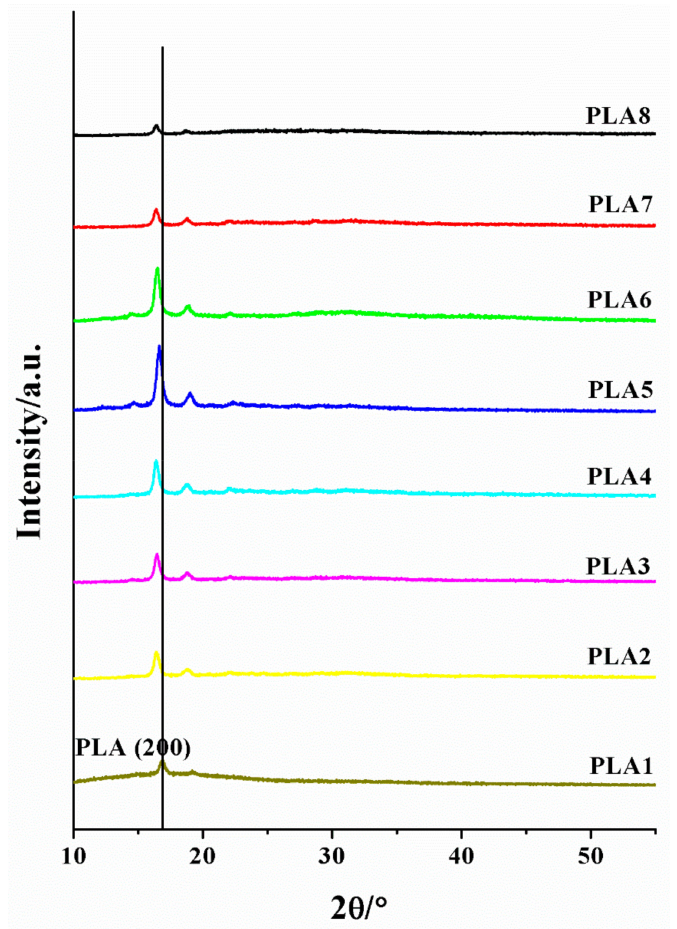
Figure 5. XRD of composite films. 2 θ / Di ff raction peak intensity